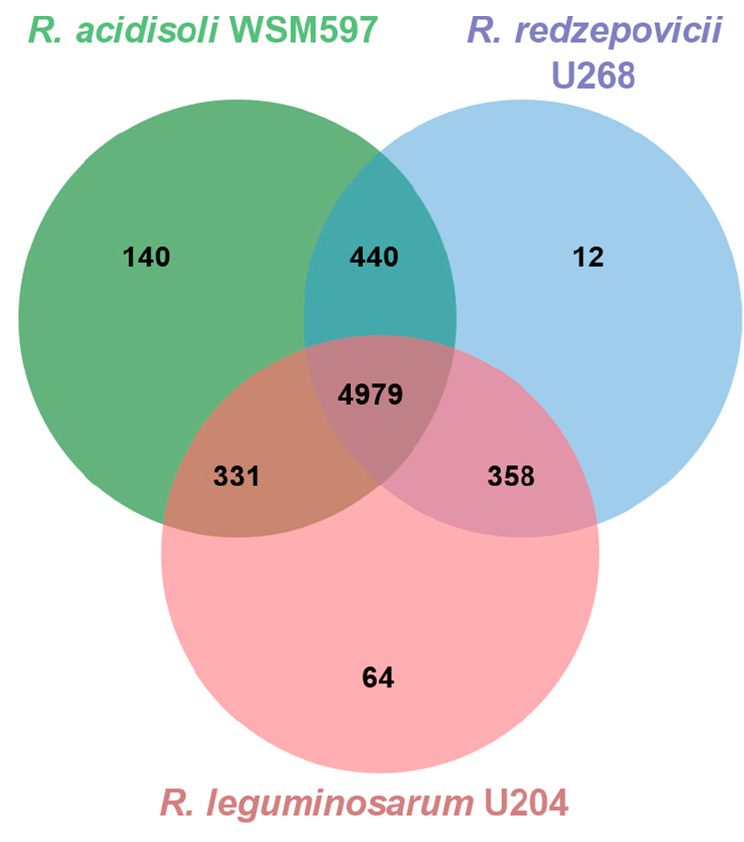
Figure 6. Venn diagram of homologous genes in R. leguminosarum U204, R. acidisoli WSM597, and R . redzepovicii U268. Overlapping regions represent homologous genes shared by 2 or 3 strains.